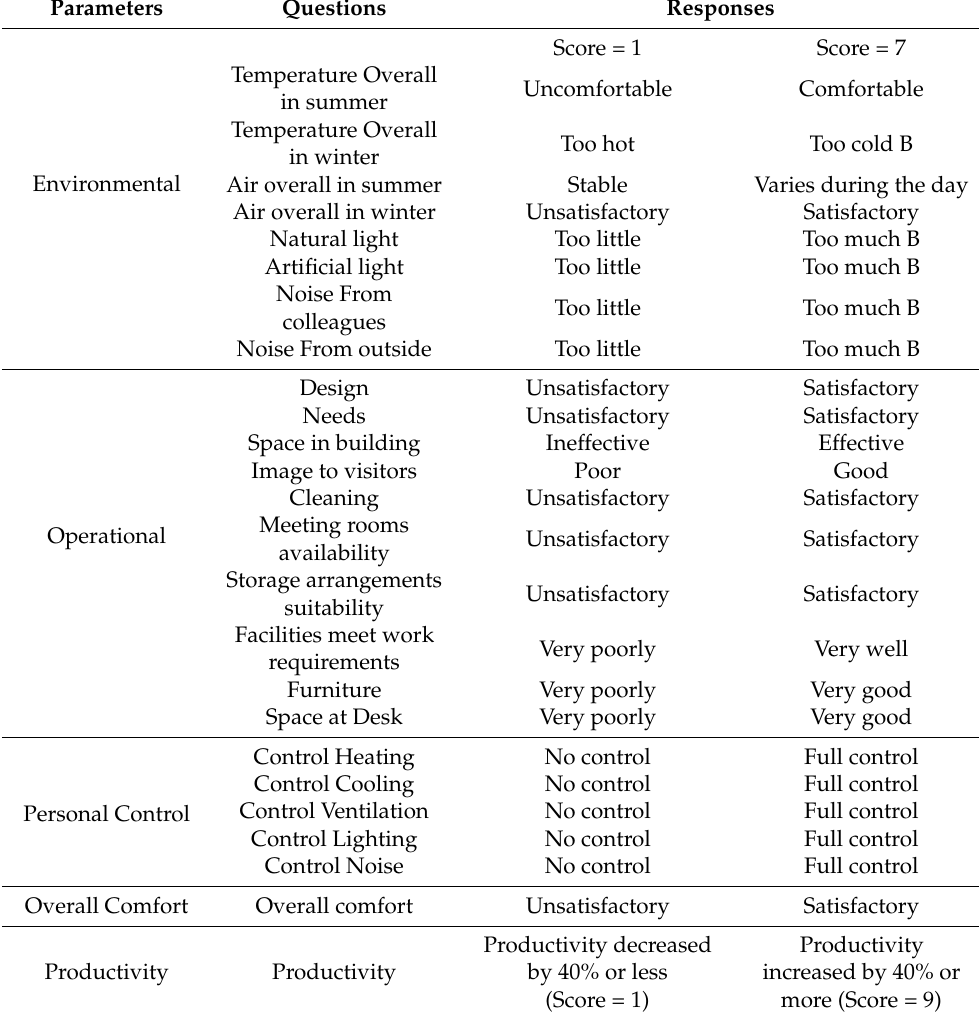
Table 1. Questions used for the POE